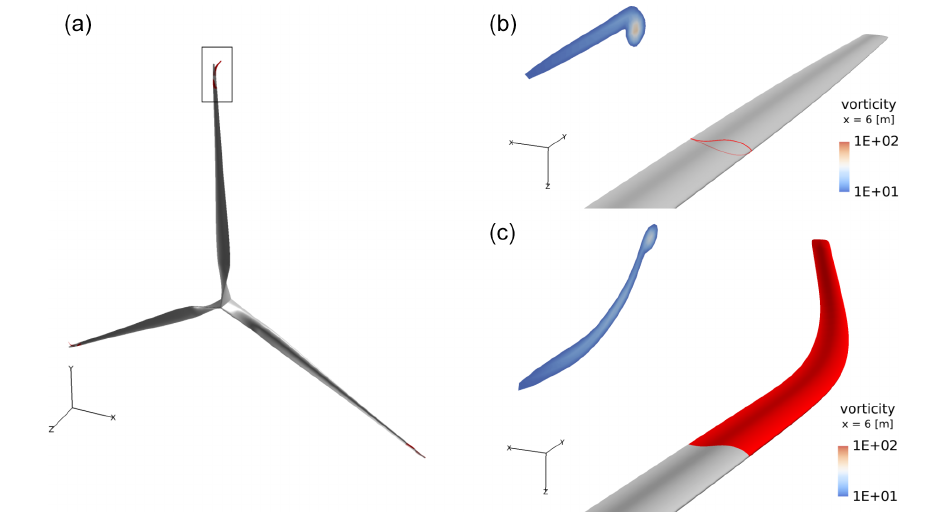
Figure 11. Tip vortex visualization using the shape optimization result from grid level L1. Wind direction is along the z axis. The full rotor image (a) is a superimposed image showing both the baseline rotor (gray) with straight blades and the final rotor shape (red) with the optimized tip shapes. The tip vortex is visualized both for the straight baseline (b) and for the final optimized tip shape (c) to show that it is smeared out and moved away from the rotor